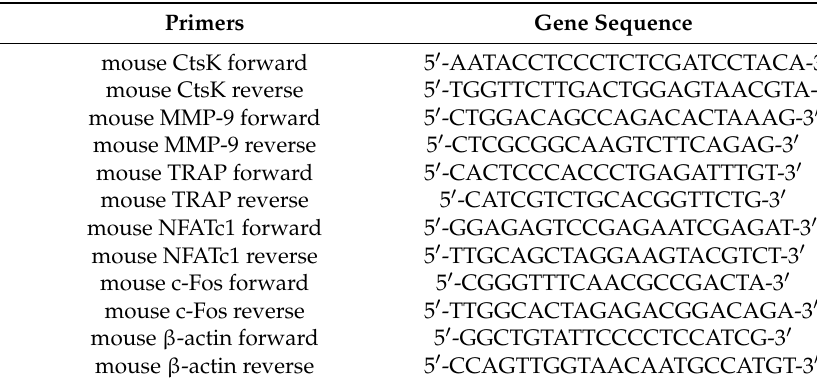
Table 1. Sequences of primers used in Real-time